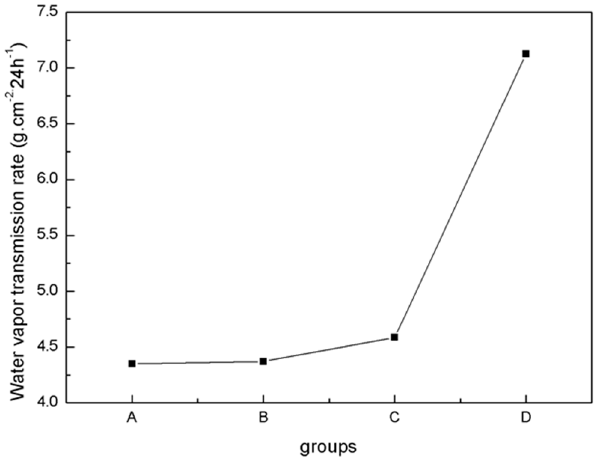
Figure 4. Water vapor transmission rate determined using the cup method.